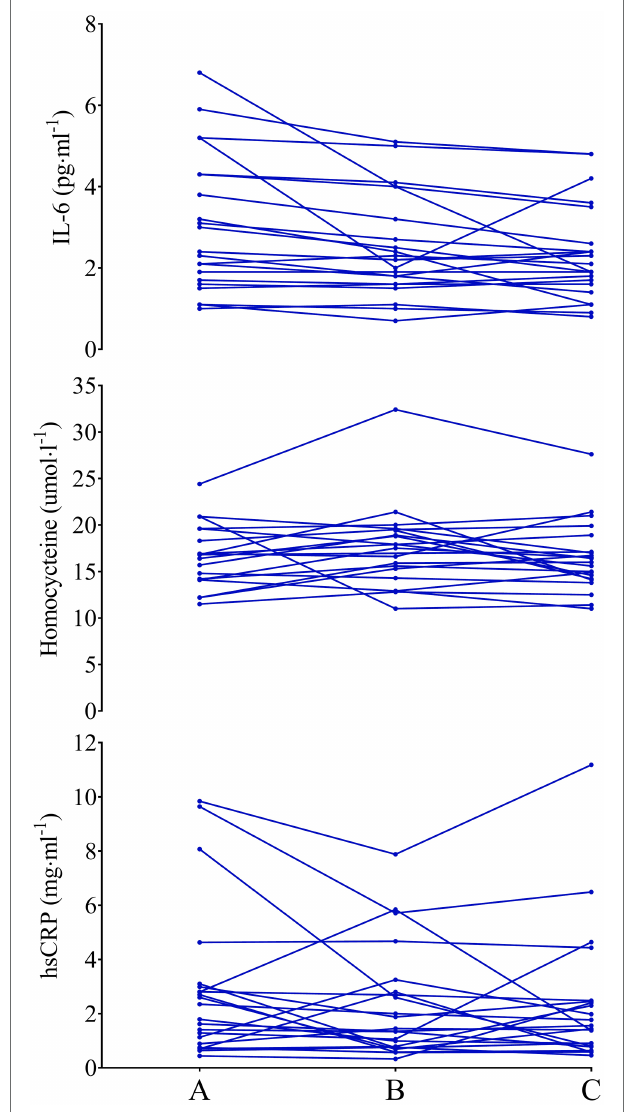
FIGURE 2 | IL-6 (top), homocysteine (middle), and high-sensitivity C-reactive protein (hsCRP; bottom) in a group of previously sedentary (SED) older men and LEX older men. Data are presented as mean ± SD, plus individual data points. *Group differences at this experimental phase at the P < 0.05 level. A = SED group difference from phase A at the P < 0.05 level. B = SED group difference from phase B at the P < 0.05 level. C = SED group difference from phase C at the P < 0.05 level.